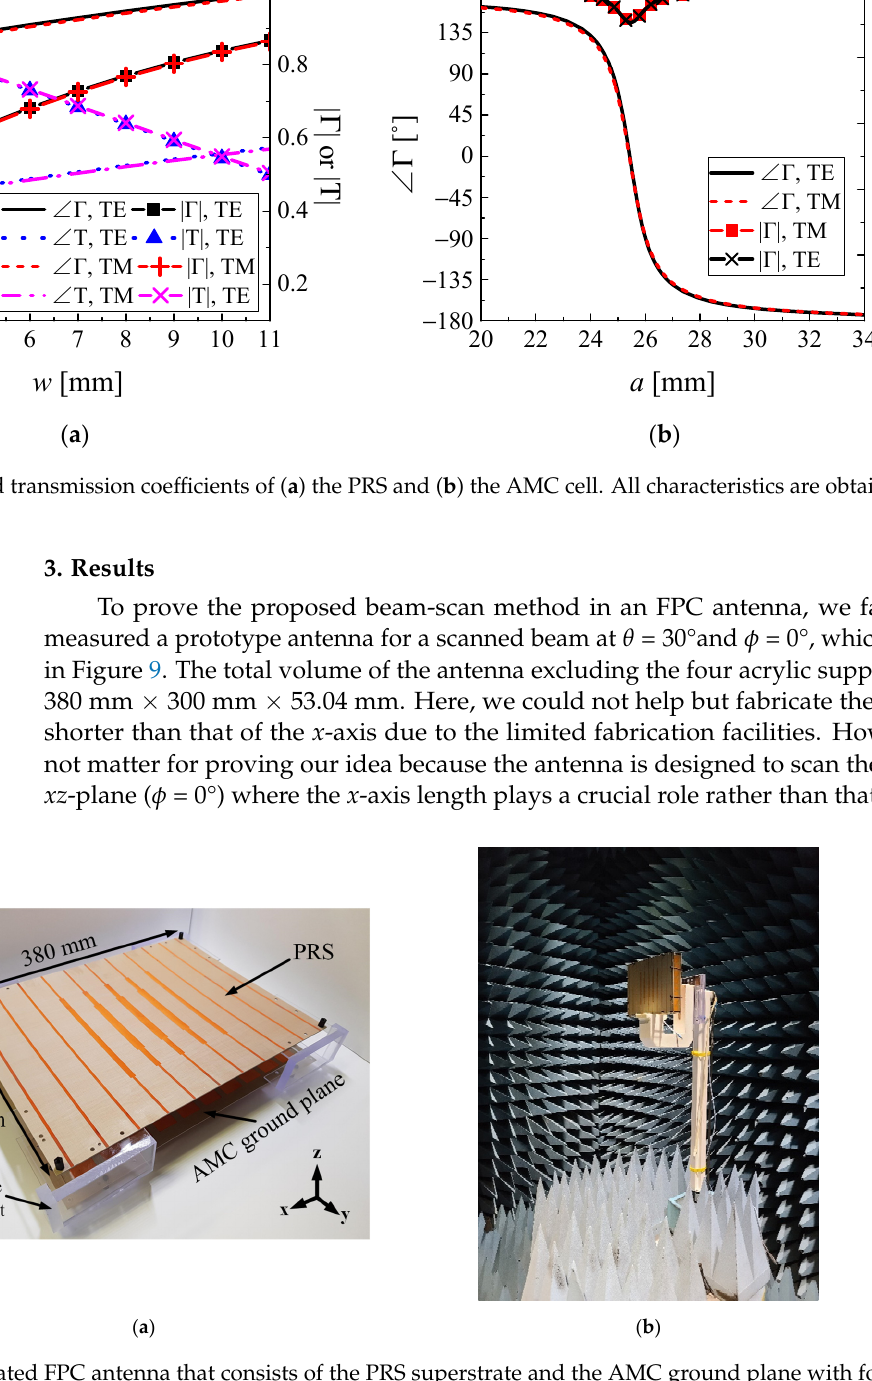
Figure 7. Unit cell simulations for two different incident modes of ( a ) a transverse electric (TE) and ( b ) a transverse mag- netic (TM) with the incidence angle α .